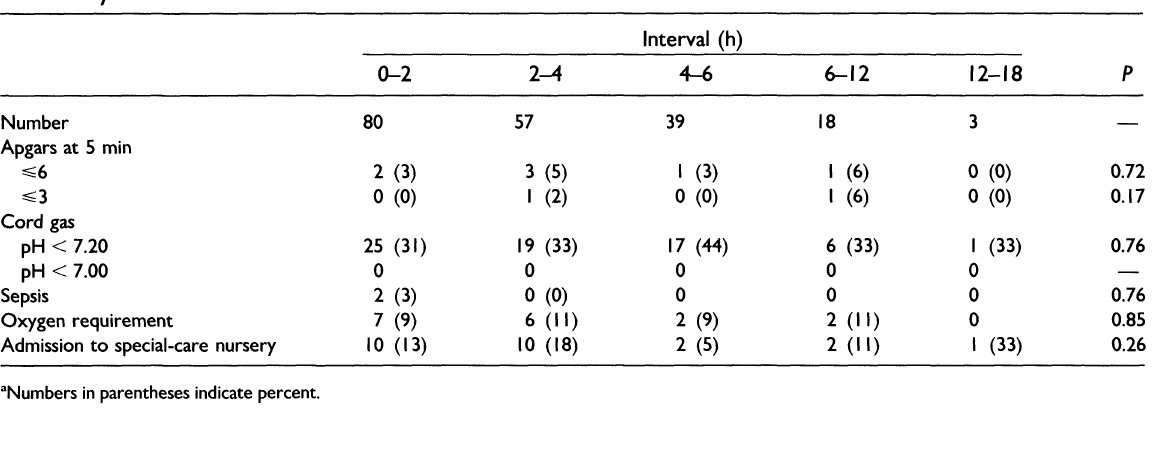
TABLE 4. Neonatal outcome parameters according to the interval from the diagnosis of chorioamnionitis to